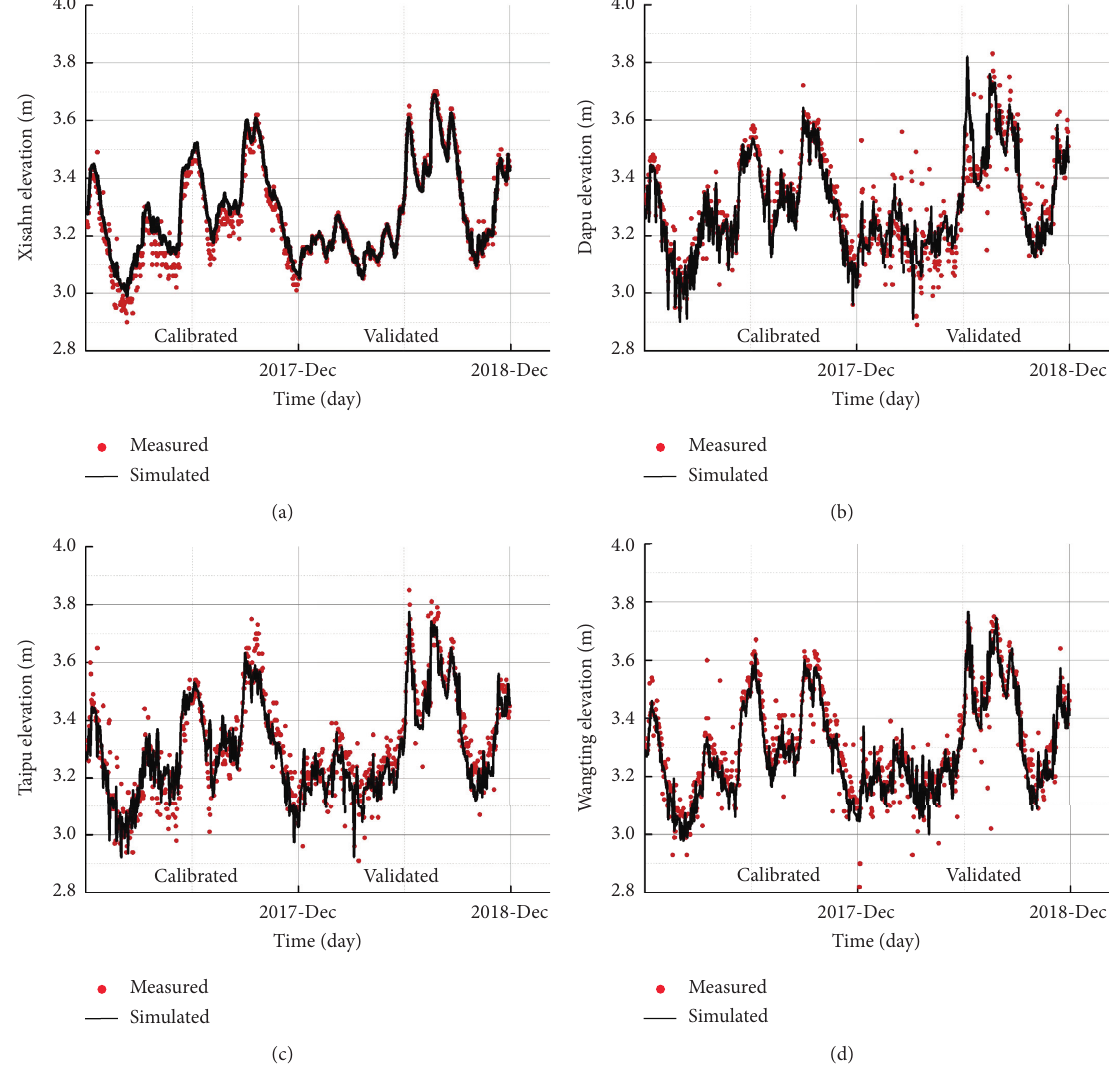
Figure 4: Calibration and verification of surface elevation: (a) Xishan, (b) Dapu, (c) Taipu, and (d) Wangting monitoring station elevations.